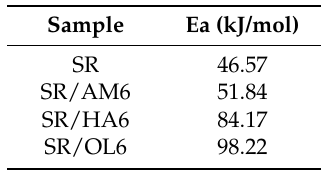
Table 4. Activation energy values of SR/POSS composites.